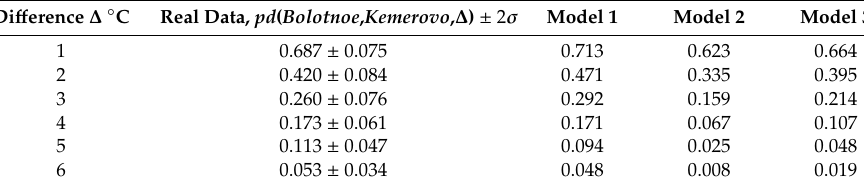
Table 6. Probability pd ( Bolotnoe , Kemerovo , ∆ ) , Area 1, 15 January.